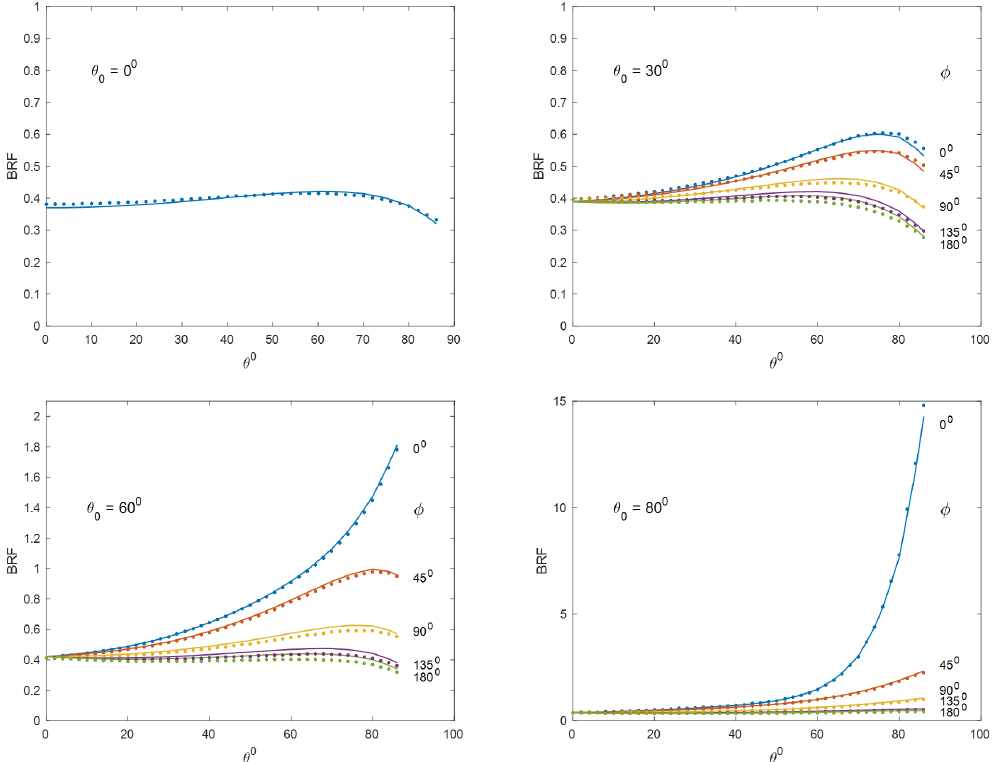
Figure 6. BRF of white ice with τ = 8.5 and a = 3.333mm at 885nm, calculated with the RAY code (dots) and the asymptotic formula (curves).